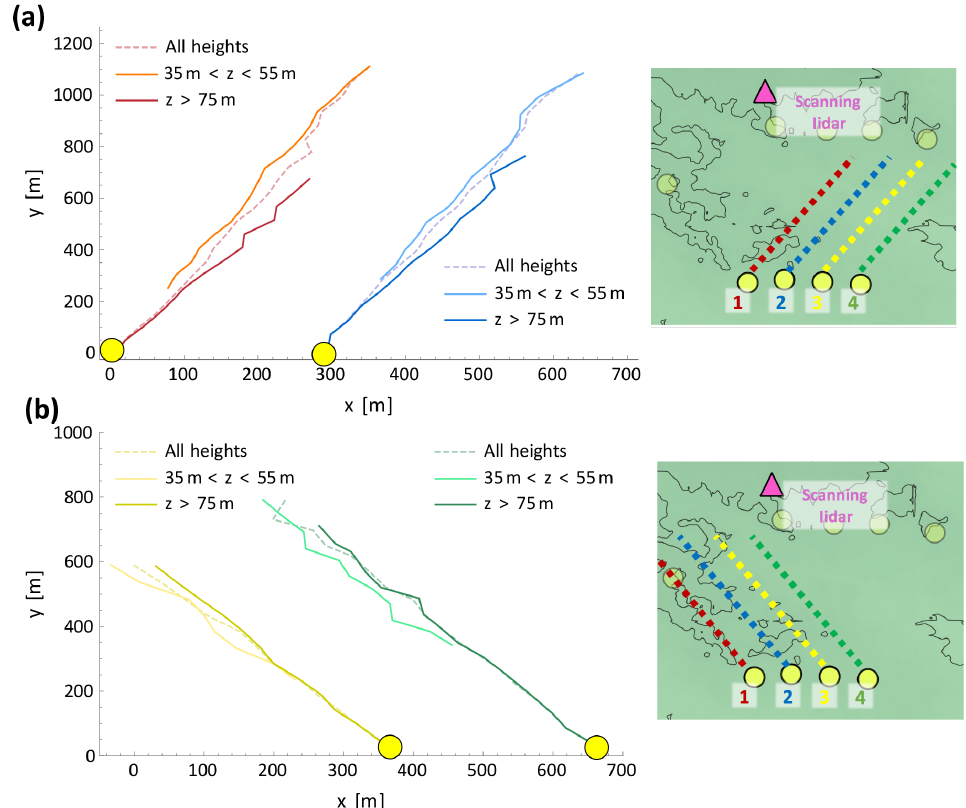
Figure 11. (a) Wake centerlines for an outer (on the left) and inner (on the right) turbine, from the PPI scans measurements during the 02:30–03:30UTC (21:30–22:30LDT) time period, 26 August 2013. (b) Wake centerlines for an inner (on the left) and outer (on the right) turbine; data from the 09:30–10:30UTC (04:30–05:30LDT) time period, 23 August 2013. Dashed lines represent the median values of wake centerlines, while the continuous lines show results at different vertical levels: for each wake, light colors refer to measurements between 35m and 55ma.g.l., while darker colors represent data points with a vertical height greater than 75m. Yellow dots show the position of wind